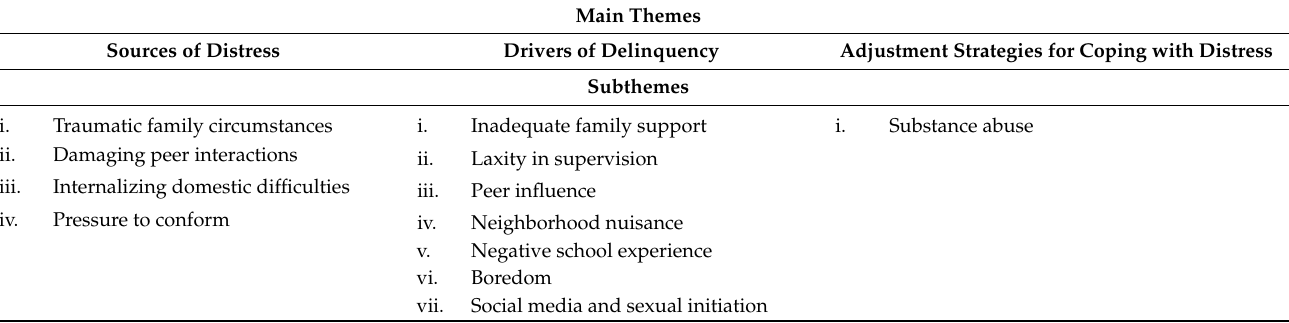
Table 2. Themes of